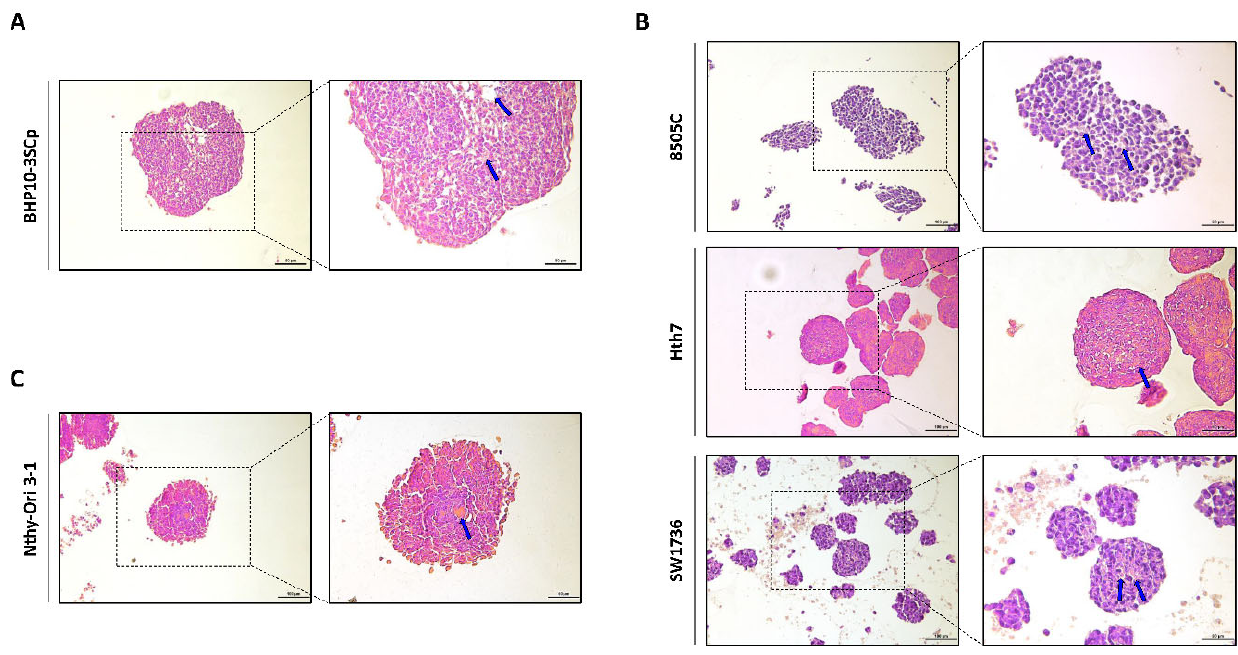
Figure 3. Hematoxylin and eosin (H&E) staining of 3D spheroids. Representative hematoxylin and eosin staining images. ( A ) Papillary thyroid cancer cell line. ( B ) Anaplastic thyroid cancer cell lines. ( C ) Thyroid follicular epithelial cell line. Blue arrow indicated eosin staining showing necrosis. Scale bar: 50 μ m.